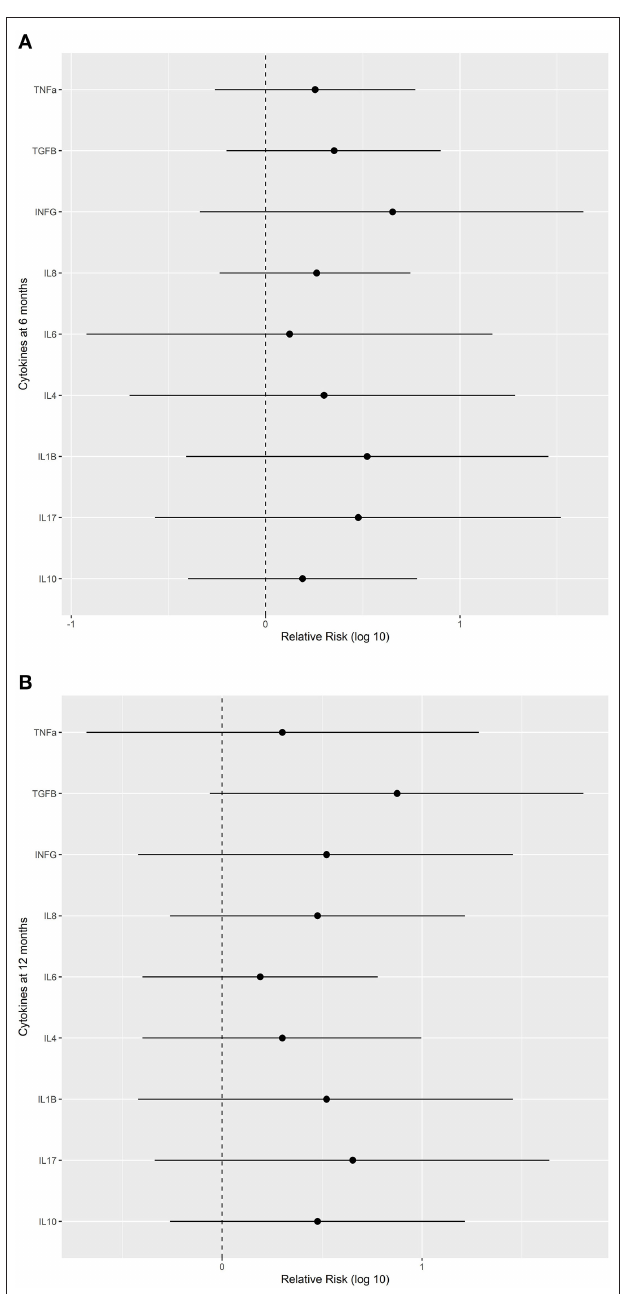
FIGURE 5 | Relative risks (with 95% confidence intervals) of improvement in levels of selected cytokines in the Probiotics group vs. Placebo. (A) after treatment for 6 months (when treatment was discontinued) and (B) at the end of the study. IFN, interferon; IL, interleukin; TGF, transforming growth factor; TNF, tumor necrosis